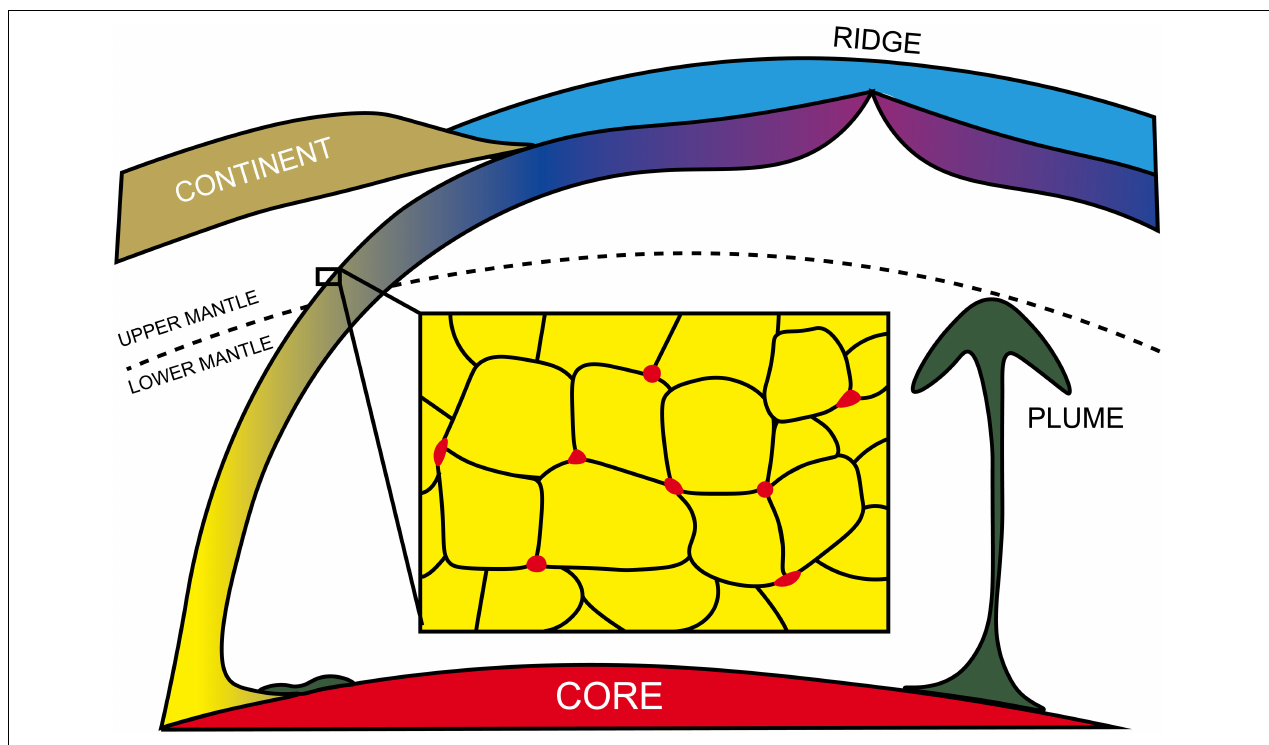
FIGURE 8 | In Earth’s mid-mantle (up to 23 GPa), slab-derived Fe–C melt is expected to be trapped as isolated pockets and would not percolate through silicate matrix.